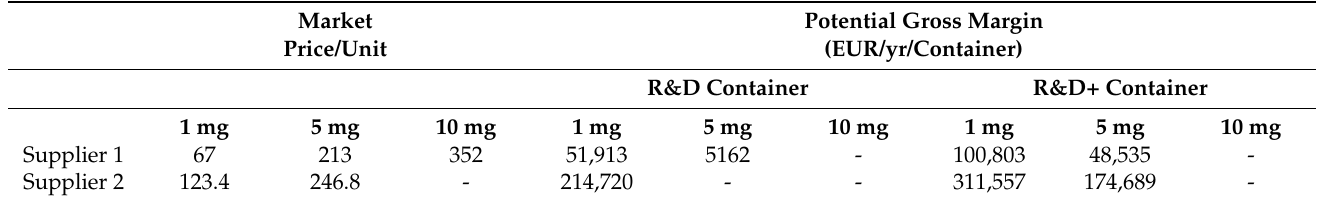
Table 7. Market price per unit of ingenol-mebutate from laboratory suppliers. Calculation of the potential gross margin per year and per container by comparison of the cost price in “R&D” and “R&D+” containers with luminosity of 500 PAR and the ethyl acetate at 120 ◦ C extraction method, for each selling unit (1 mg; 5 mg; 10 mg). Supplier 1: MedChemExpress; supplier 2: